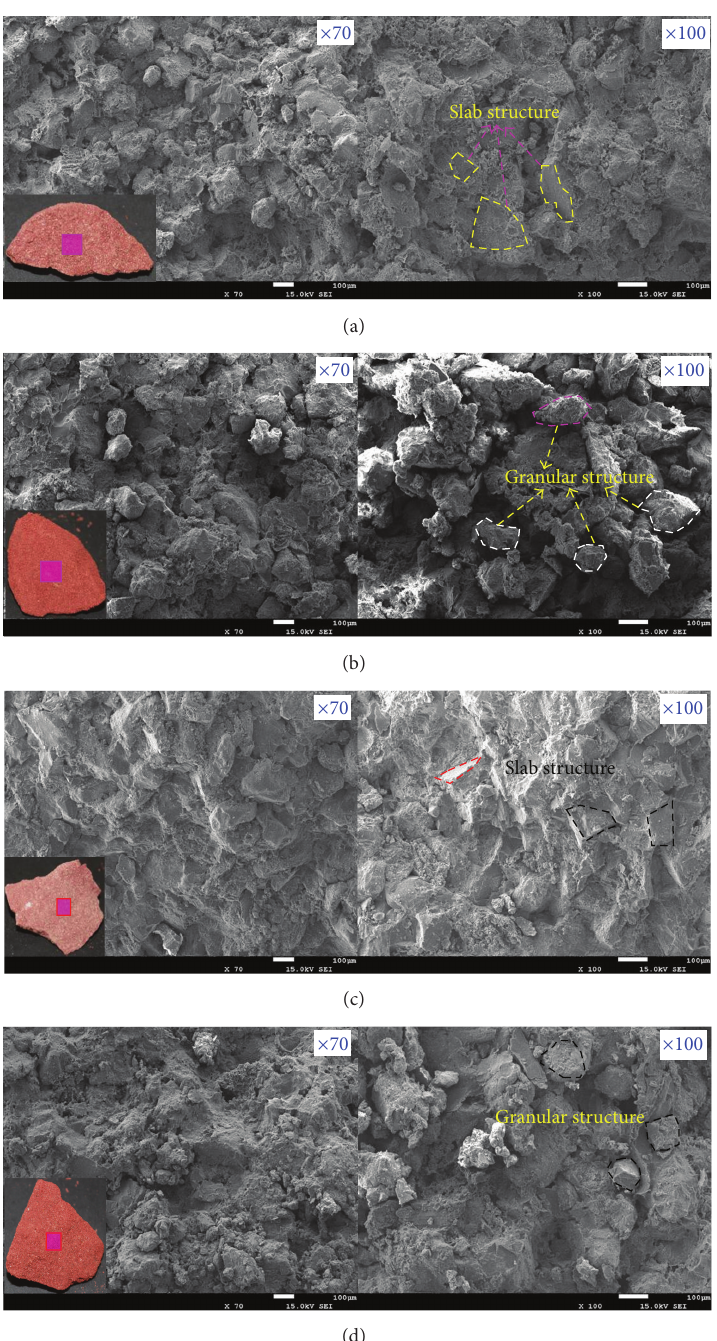
Figure 9: Microstructural characteristics of the Zigong argillaceous siltstone with different degree of weathering (SEM images): (a) natural highly weathered; (b) saturated highly weathered; (c) natural moderately weathered; and (d) saturated moderately weathered.